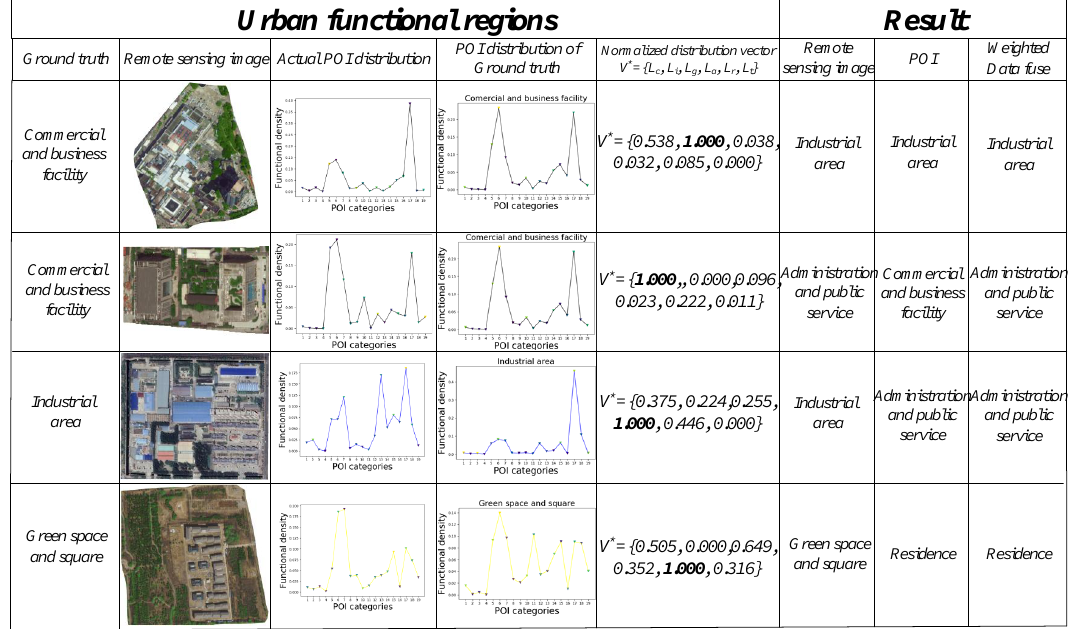
Figure 15. Some false examples of our proposed method in different situation. The special results of our proposed method in different situation. The ground truth represents the urban region function of example area. The remote sensing image represents the spatial geographic scenery of this area. The Actual POI distribution represents the actual POI distribution in this area. The POI distribution of ground truth represents the POI distribution in this urban functional region. The Normalized distribution vector V ∗ = { L C , L I , L G , L A , L R , L T } represents the similarity calculated by our distance metric